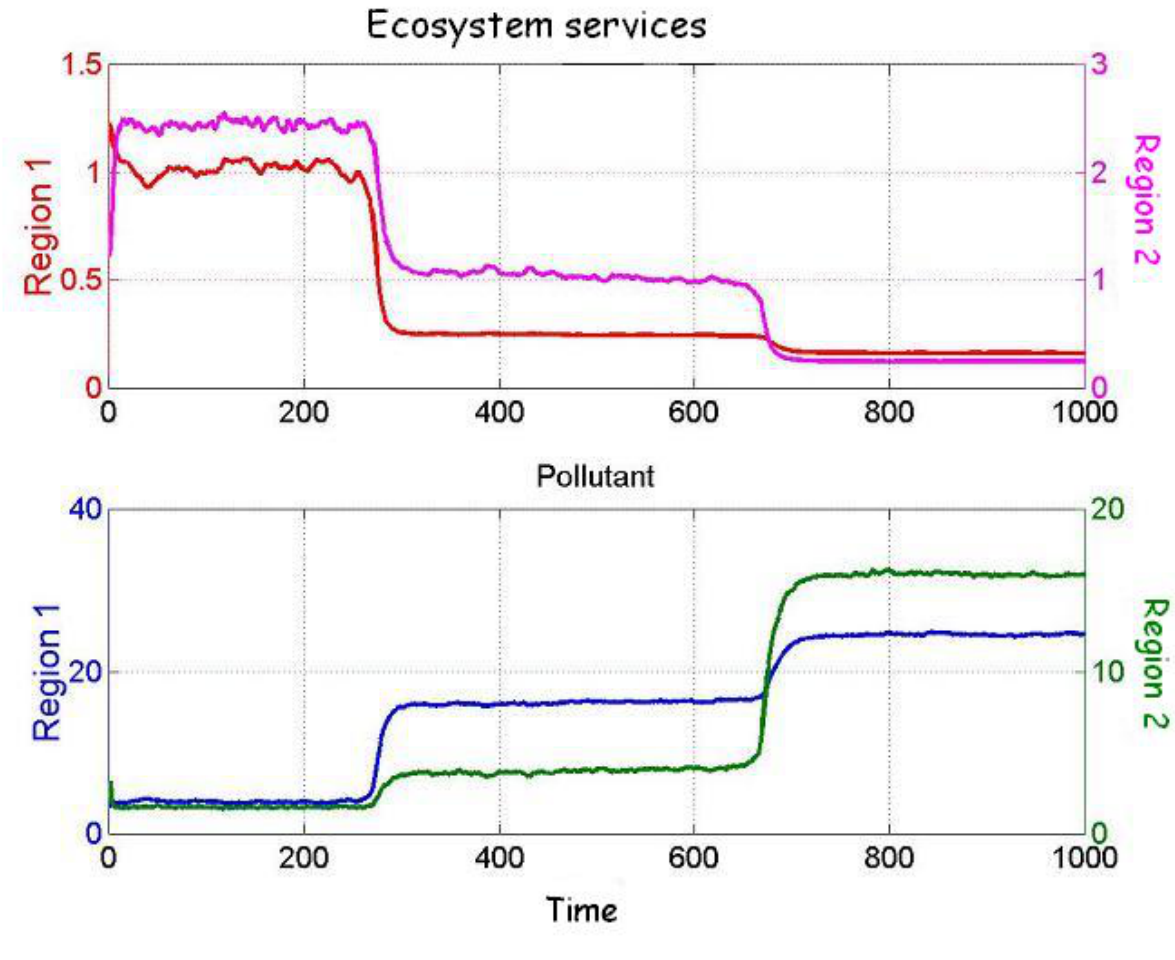
Fig. 6 . Time series of ecosystem services (upper panel) and pollutant (lower panel) in each region vs. time as M (pollution discharge rate in region 1) increases linearly from 2.0 to 2.1. Other parameters: r 1 (renewal rate of the ecosystem service) = 1; h (effects of extracting or using the ecosystem services) = 0.5; k (impact of the pollutant on the renewal rate of the ecosystem service) = 0.5; M (pollution 2 discharge rate in region 2) = 0.75; c (decay rate in region 1) = 0.05; c (decay rate in region 2) = 0.1; D 1 2 (transport rate between regions) = 0.1; s (maximum sequestration rate) = 0.5; m (the pollutant level at which sequestration is half the maximum rate) =5; q (which determines the slope of f(P) near P ) = 6; s = 0.05. P stands for amount of pollutant, and f(P) scales the sequestration to the amount of